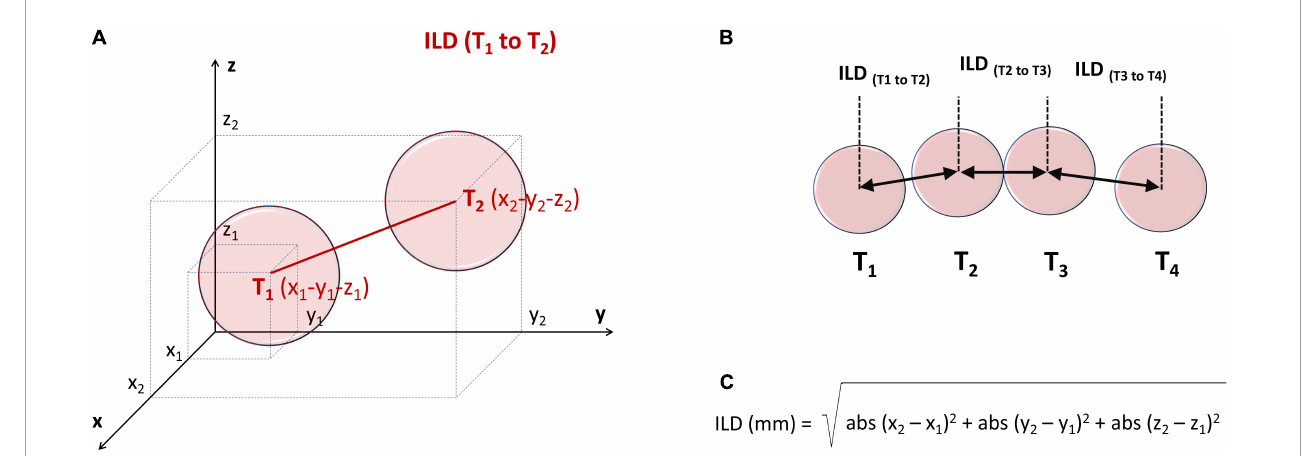
FIGURE2 Principles of off-line measurement of ILD between the centers of two contiguous ablation lesion tags, T1 and T2 (A,B) , using the 3D Pythagorean Theorem equation (C) . For each lesion tag the AutoMark module reported x-y-z coordinates (on 3 orthogonal axes) from the reference system point. ILD, inter-lesion distance.